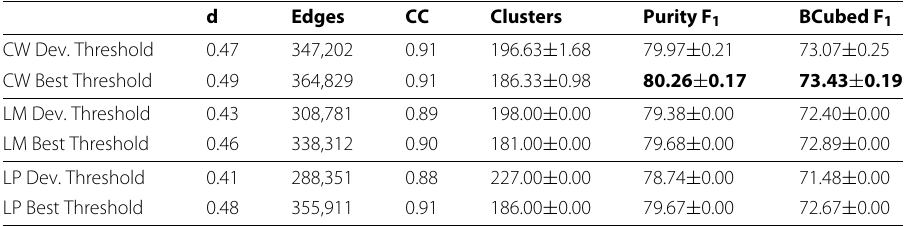
Table 4 Semantic frame induction results on the test data d Edges CC Clusters Purity F 1 BCubed F 1 CW Dev.